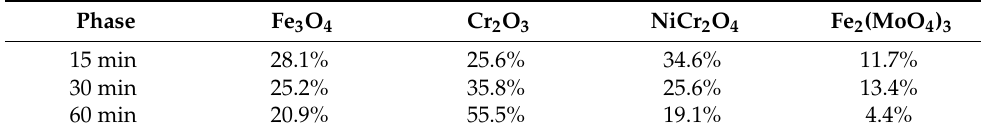
Table 3. Fraction of phases based on XRD after oxidation at different times.